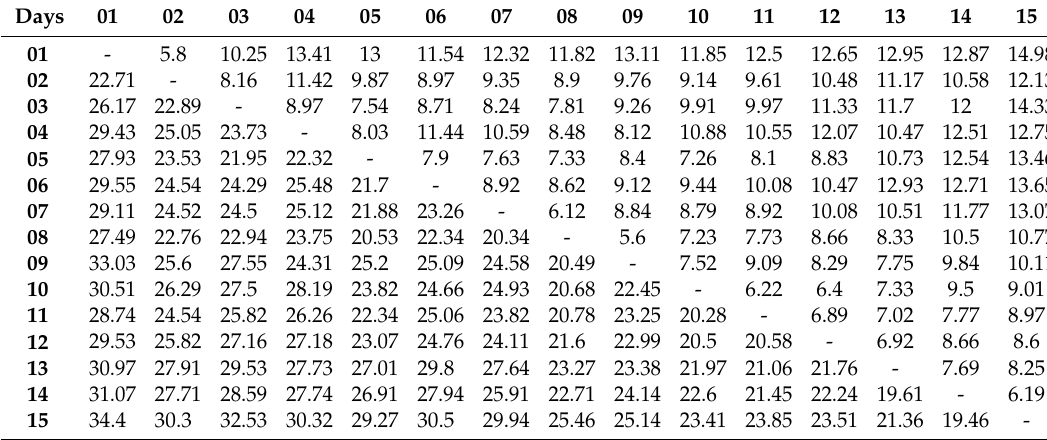
Table 1. CNN vs SSAE-r. Performance comparison using pairs of days. The upper diagonals show the classification error with CNN for the corresponding pair of days, while the lower diagonal is for SSAE-r. For both CNN and SSAE-r, the classification was performed with bipolar raw EMG data.